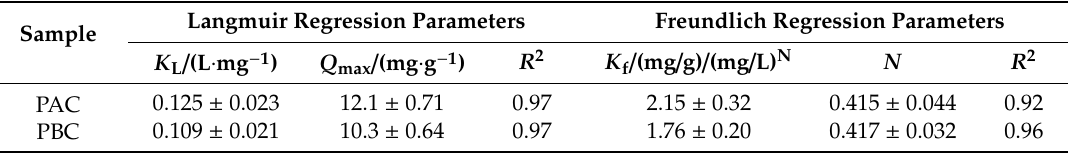
Table 2. Regression parameters of Langmuir and Freundlich model for the sorption of Strontium by